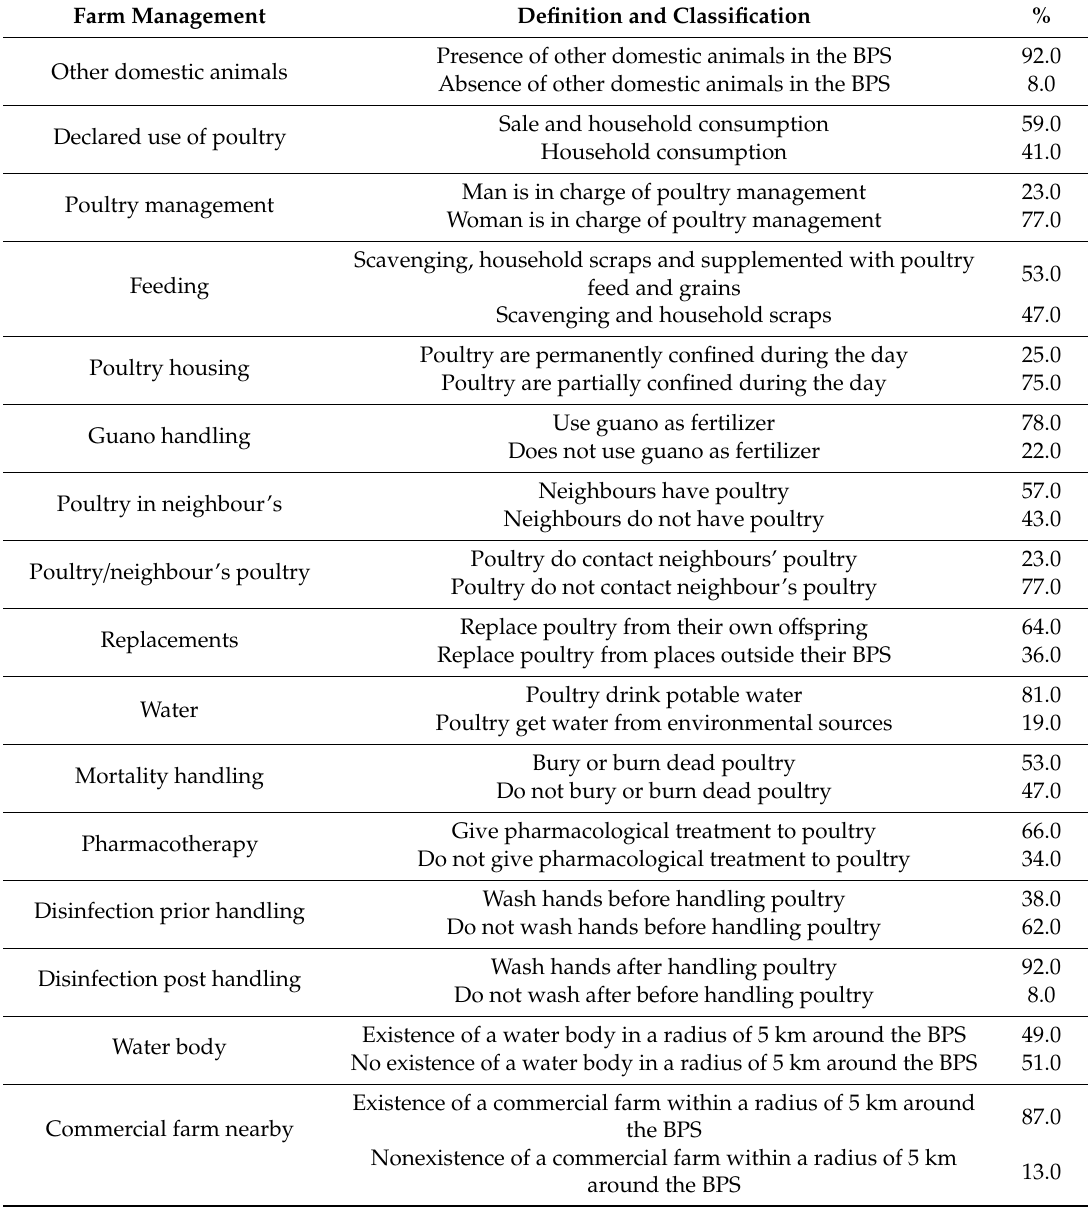
Table 1. Variables considered for the characterization of poultry handling and biosecurity conditions in BPS that keep poultry in central